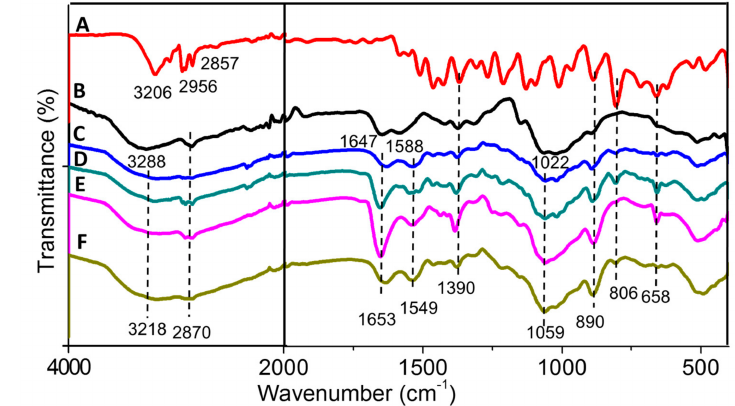
Figure 2. FTIR spectrum of ( A ) pure hexaconazole, ( B ) CEN and chitosan–hexaconazole nanoparticles prepared at various concentrations of TPP, ( C ) 2.5, ( D ) 5, ( E ) 10, and ( F ) 20 mg / mL.